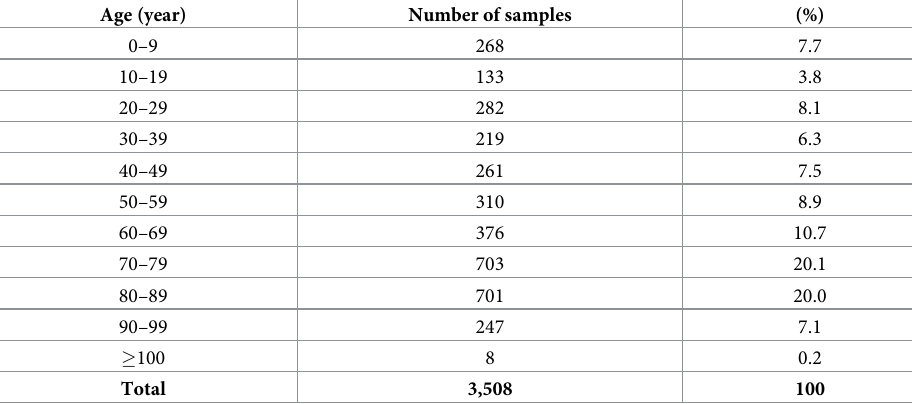
Table 1. Age distribution of the 3,508